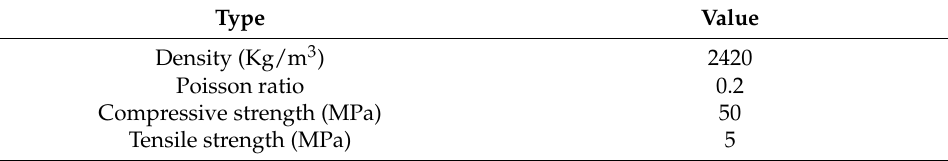
Table A2. Bridge material (C50 concrete).